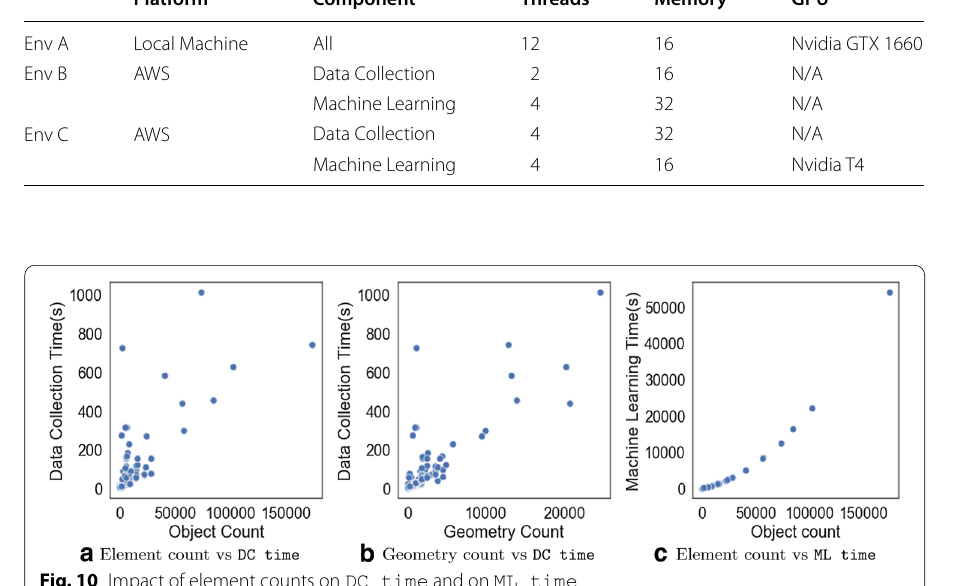
Fig. 10 Impact of element counts on DC time and on ML